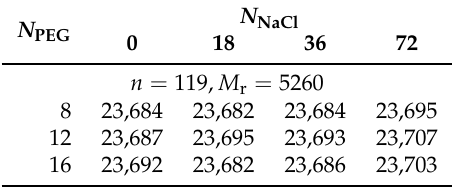
Table 2. Numbers of water molecules in production runs of all the simulated